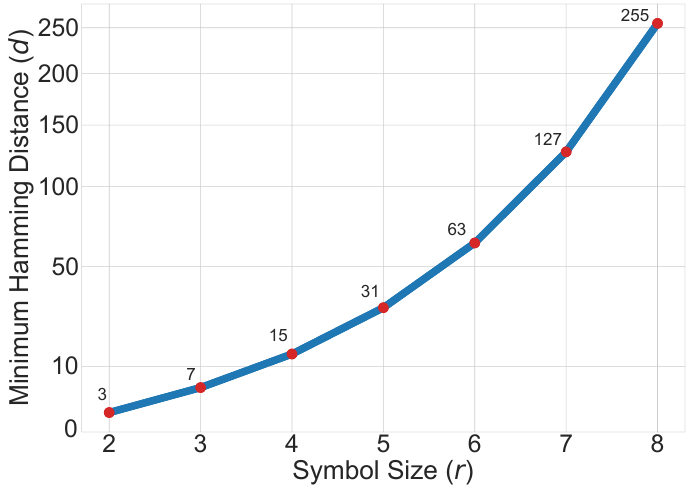
Figure 6. Symbol size effect on the minimum hamming distance while k = 1. It is worth noting that an increase in the symbol size also decreases the ratios of DTP (green category) and CFP (i.e., the category in a shade of orange) and also increases the ratio of CTN (i.e., the category in shade on orange). This indicates that, for larger symbol sizes, RS Codes have a stronger detection capability than correction capability. RS Codes